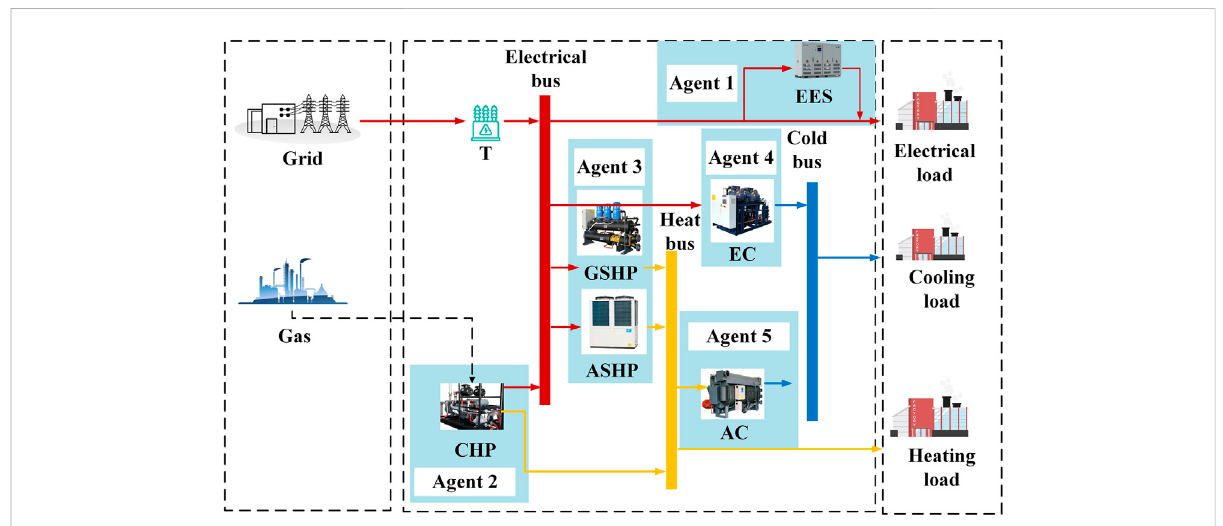
FIGURE 1 Structure of park-level integrated energy